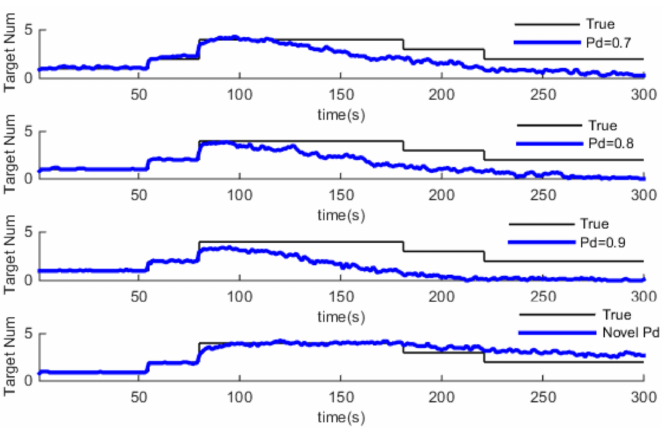
Figure 10. Comparison of target number estimation with different P d in clutter intensity κ k = 10.